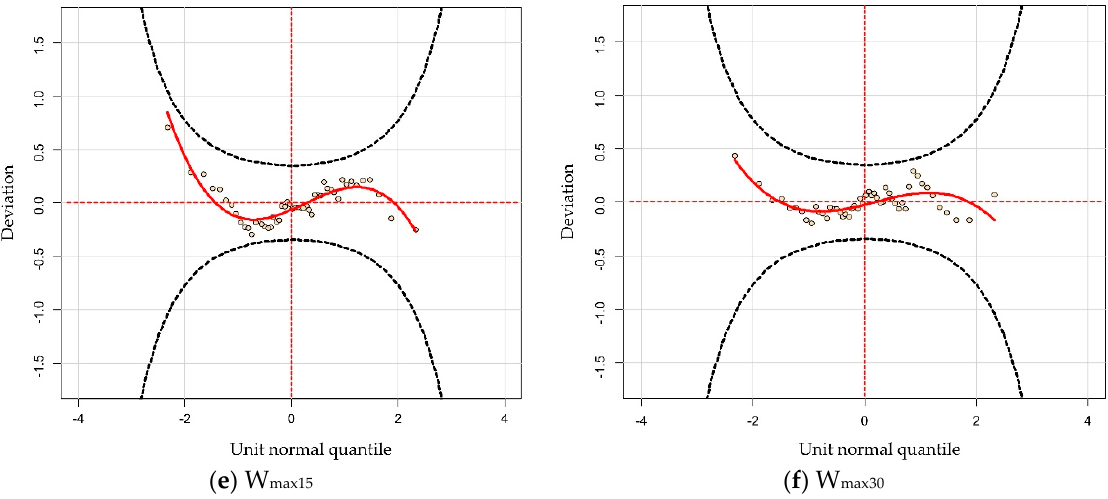
Figure 6. Worm plots of model 2 residuals. The two black dotted lines correspond to the 95% confident limits. Table 8. Residual distribution moments and Filliben coefficients for optimal fitting distribution of snowmelt flood time series (model